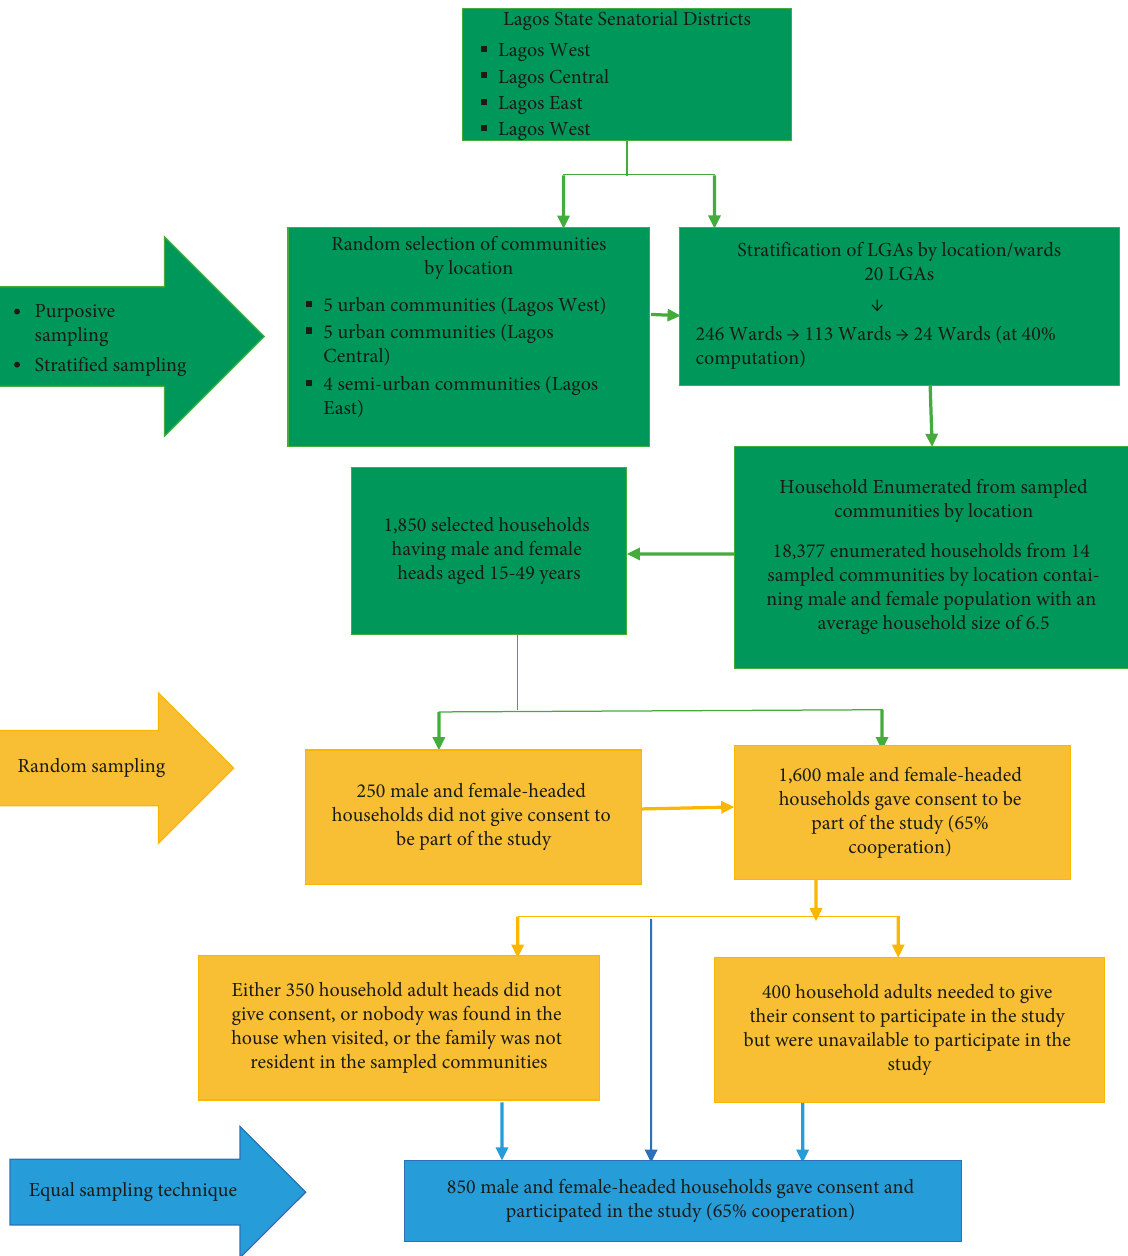
Figure 1: Flowchart showing sampling techniques used to select survey households and the selection of the household heads that participated in the